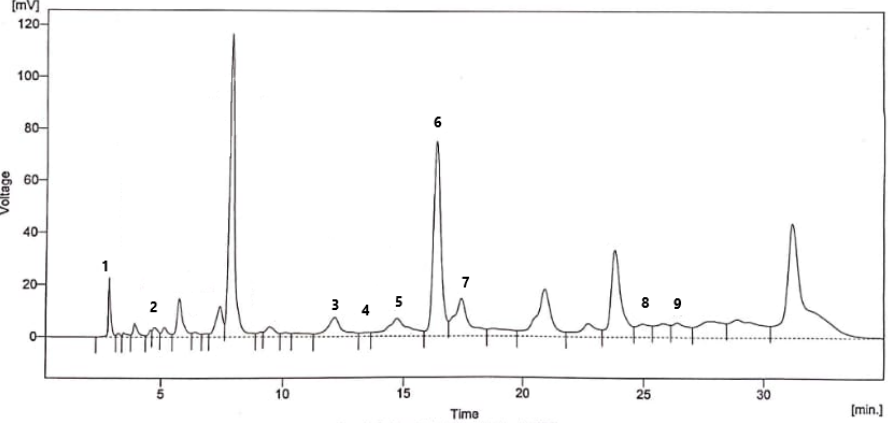
Figure 1. HPLC-UV chromatogram of the ethanolic flaxseed extract at λ = 280 nm. Peak numbers refer to Table 3.